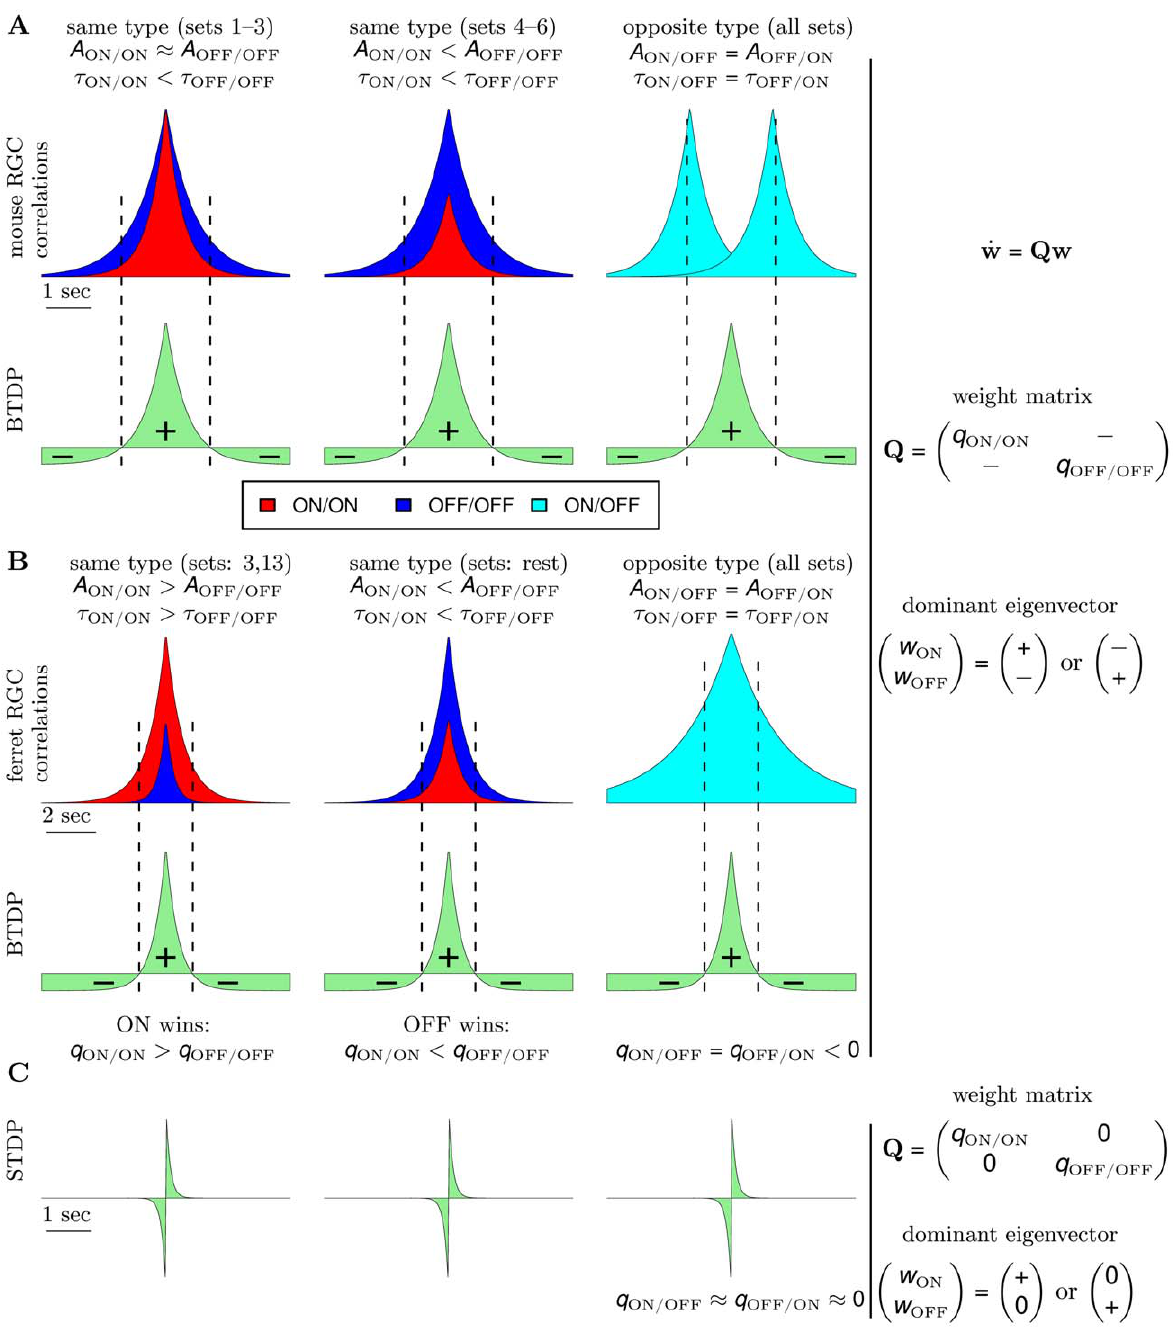
Figure 7. Insights into ON/OFF segregation from the linear model. (A) (left) ON dominance. Factors which determine segregation for data sets 1–3 (data set 1 in Figure 4A) with similar correlation peaks of ON/ON and OFF/OFF pairs. Segregation is the result of a trade-off between the relative areas of the input correlation functions for ON/ON (red) and OFF/OFF (dark blue) pairs integrated by the positive and negative parts of BTDP (green). BTDP favors ON segregation because the smaller area of the ON/ON correlation under the negative part of BTDP (denoted by { ) dominates the larger area of the OFF/OFF correlation under the positive part of BTDP (denoted by z ). Therefore, q ON = ON w q OFF = OFF in the plasticity matrix Q (Equation 1). (middle) OFF dominance. Factors which determine segregation for data sets 4–6 (data set 4 in Figure 4B) with larger correlation peaks of OFF/OFF than ON/ON pairs. BTDP favors OFF segregation because the larger area of the OFF/OFF correlation under the positive part of BTDP dominates the smaller area of the ON-ON correlation under the negative part of BTDP, such that q ON = ON v q OFF = OFF in the plasticity matrix Q (Equation 1). (right) The reflected (about 0 seconds) input correlations between cells of different type (light blue) have a larger part of their areas under the negative part of BTDP, ensuring negative off-diagonal terms x in Q (Equation 1) and introducing competition. (B) (left) Input correlation functions for two of the 15 ferret data sets illustrate dominance of ON segregation. (middle) Input correlation functions for the remaining 13 ferret data sets illustrate dominance of OFF segregation. (right) The input correlation function between cells of different type peaks at 0 seconds for ferret, however, the wide correlation timescale (wider than in mouse) still produces negative off-diagonal terms x in Q (Equation 1), and correspondingly, competition between the ON and OFF weights. (C) STDP drawn to scale to compare its spike integration time window with the timescale of input correlations shown in (A) and (B). The near-0 off-diagonal terms in Q (Equation 3) inhibit segregation.